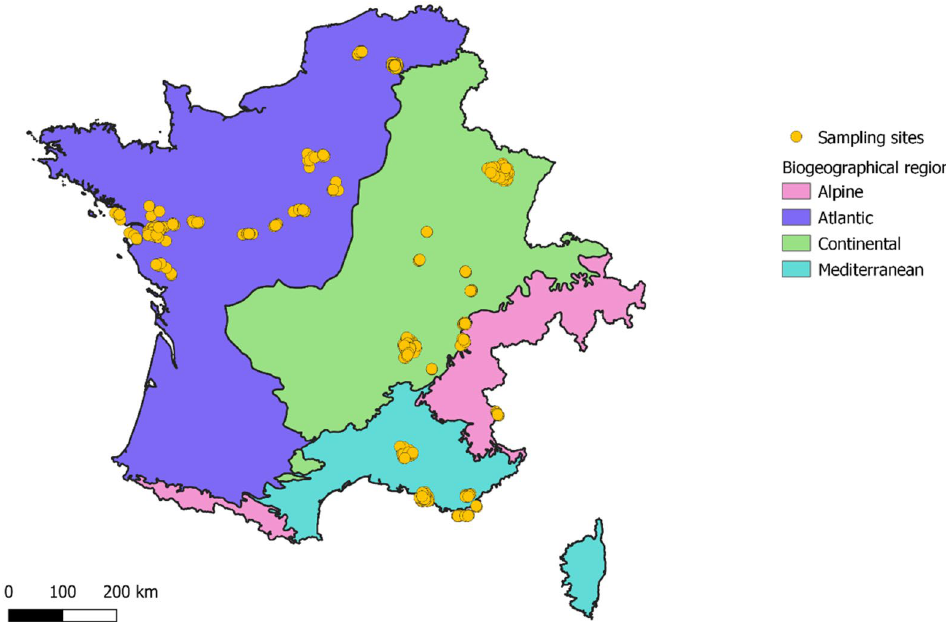
Figure 5. Grouped sampling sites (n = 532) in France, Belgium and Switzerland, with the biogeographical regions. In total, 238 sites belong to the Continental region, 178 to the Atlantic, 106 to de Mediterranean and 10 to the Alpine. This figure was generated using QGIS software, v3.10.13 (https:// www. qgis.